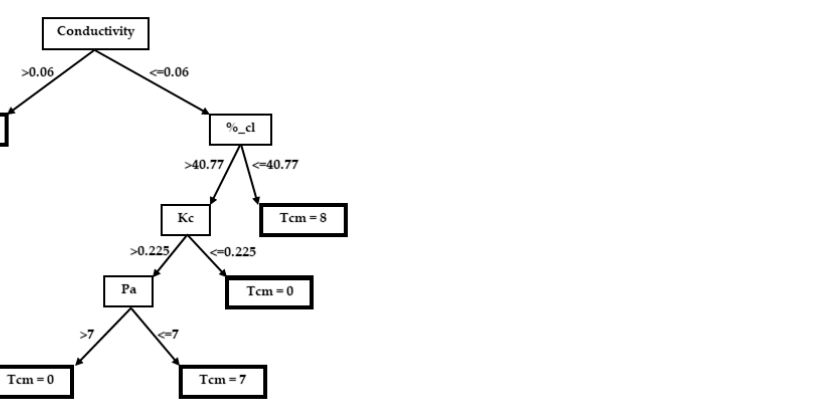
Figure 4. Decision tree for Tcm = Taeniatherum caput-medusae . The numbering inside the boxes represents the abundance–dominance index converted to Van der Maarel [40]. The other numbering corresponds to the range of values of the edaphic attributes.